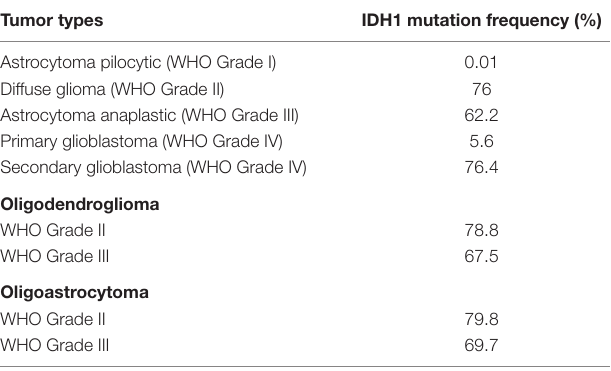
TABLe 2 | Frequency of iDH1 mutation in various tumors. Tumor